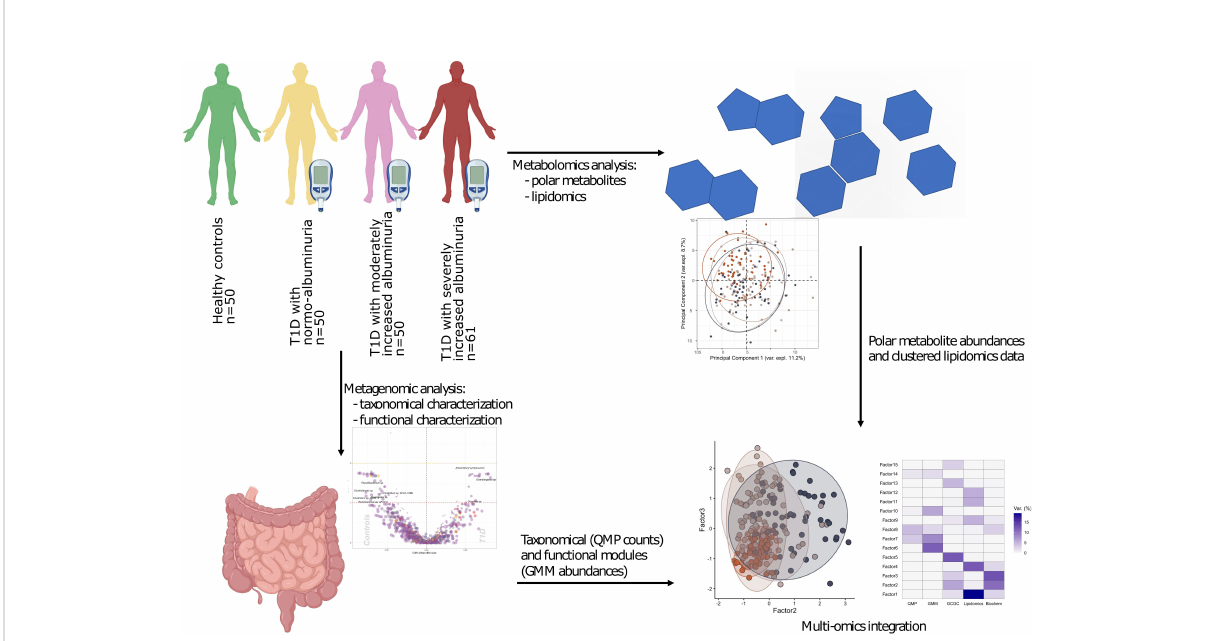
FIGURE 1 Study design and analytical overview. The study cohort comprised 50 healthy and 161 individuals with T1D, who strati fi ed on albuminuria levels: normo-albuminuria (n=50, albuminuria levels =<3.39 mg/mmol), moderately increased albuminuria (n=50, albuminuria levels =3.39 – 33.79 mg/ mmol) and severely increased albuminuria (n=61, albuminuria levels = ≥ 33.90 mg/mmol). For each study participant 1) plasma samples were collected to perform non-targeted metabolomics analysis, including both polar metabolites and lipids, and 2) faecal samples collected for metagenomics analysis. For the metagenomic samples, differences between the clinical groups at both taxonomical and functional level were assessed. Lipidomics data was clustered into highly correlated lipid clusters in order to reduce dimensionality. Finally, different omics data